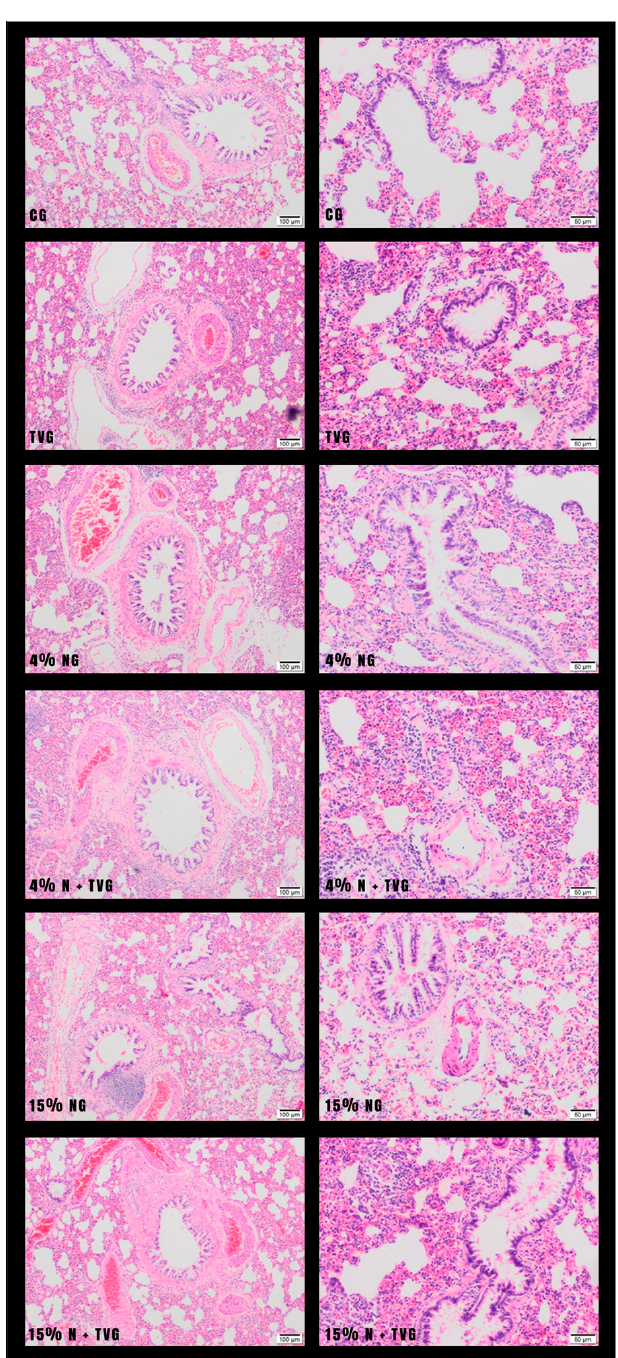
Figure 1. In control and T. vulgaris group samples, mostly normal connective tissue formation was observed around the bronchioles. Mild fibrosis was observed in the 4% NaOCl group, and intense fibrosis in the 15% NaOCl group. In addition, inflammatory cells in the alveolar lumens of the lung tissue and inflammatory thickening in the interalveolar septum were detected in the 15% NaOCl group. These findings were not evident in the 4% NaOCl group. It was observed that intense fibrosis, inflammation, and other deterioration in the 15% NaOCl group were significantly reduced with T. vulgaris application.